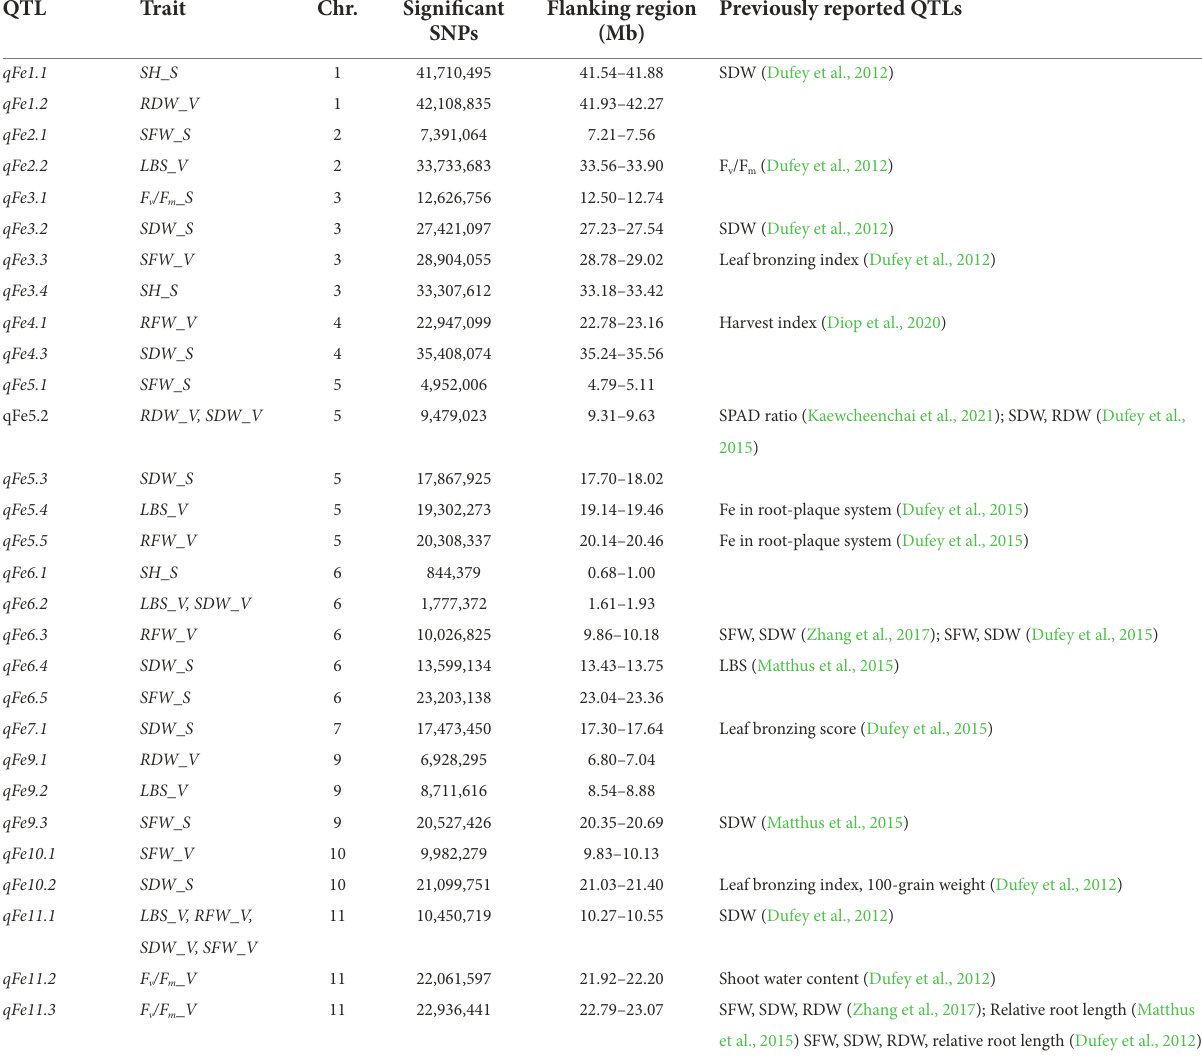
TABLE 2 Summary of identified QTLs on each chromosome significantly associated with